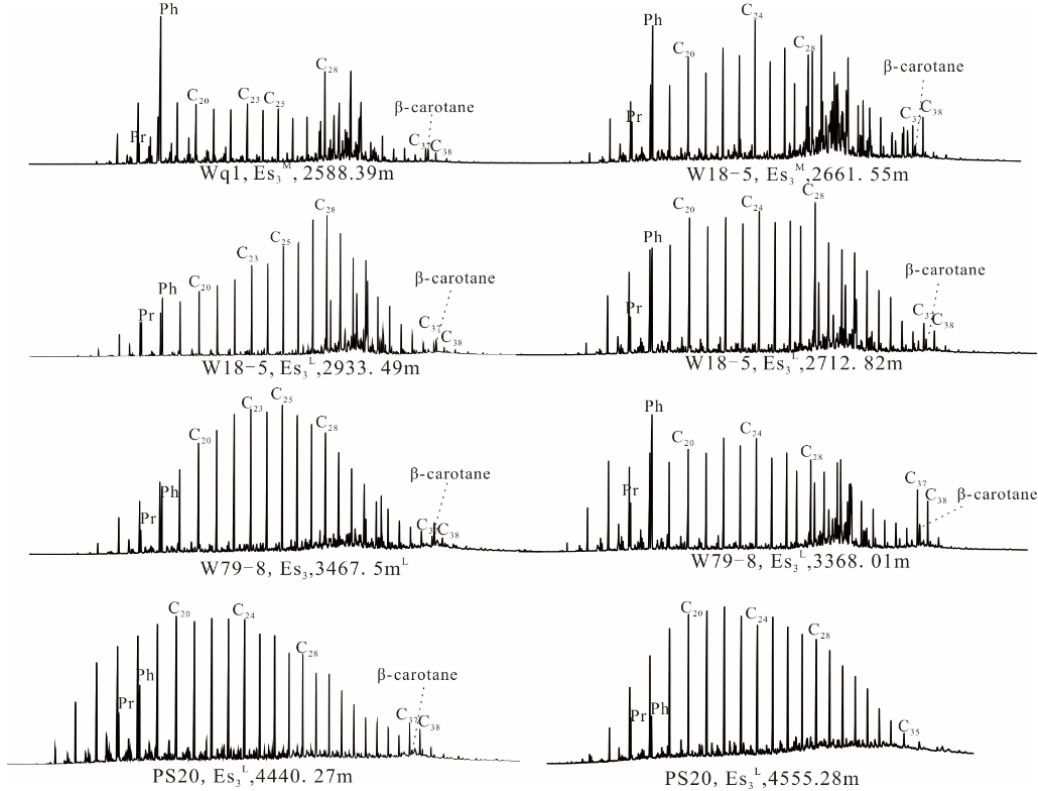
Figure 4. A diagram of the total ions of paraffins from source rocks in the study area.